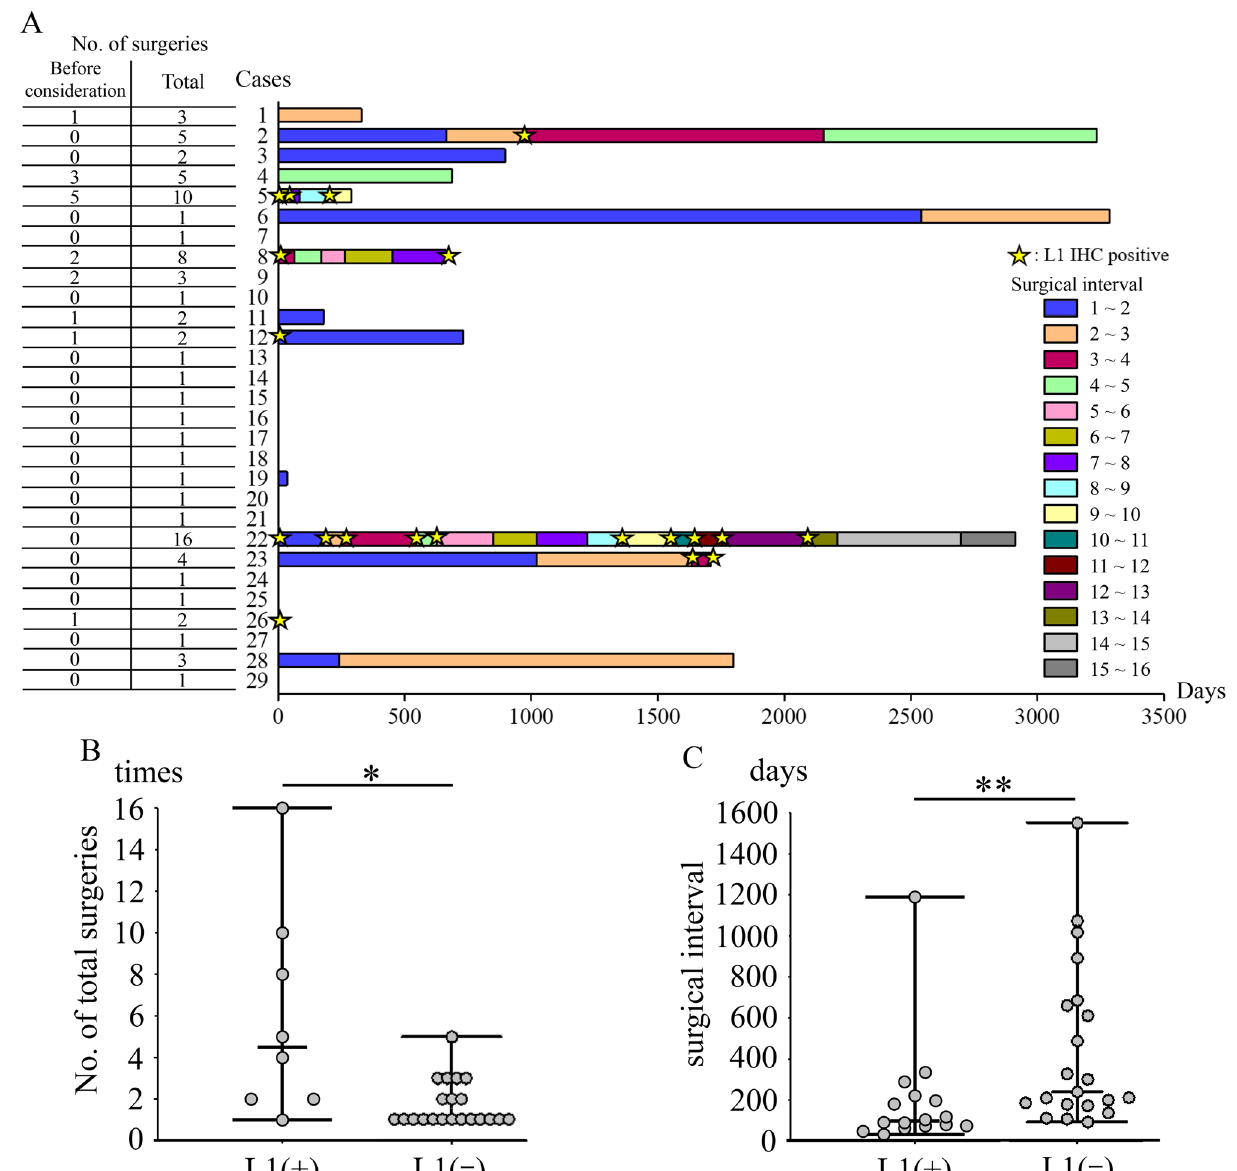
Figure 5. Association between L1 IHC and clinical severity. ( A ) HPV L1 IHC is positive in certain cases, with a high number of surgeries and short surgical intervals. The vertical axis indicates the number of cases, and the horizontal axis indicates the number of days. Colour of the bar indicates the surgical interval timing and the length represents each surgical interval. Stars indicate HPV L1 IHC positivity. ( B ) The total number of surgeries is significantly higher in L1 IHC-positive cases ( p = 0.04). ( C ) The interval between surgeries is significantly shorter in L1 IHC-positive cases ( p < 0.01). *Indicates p < 0.05 and ** indicates p < 0.01. HPV Human papillomavirus, IHC